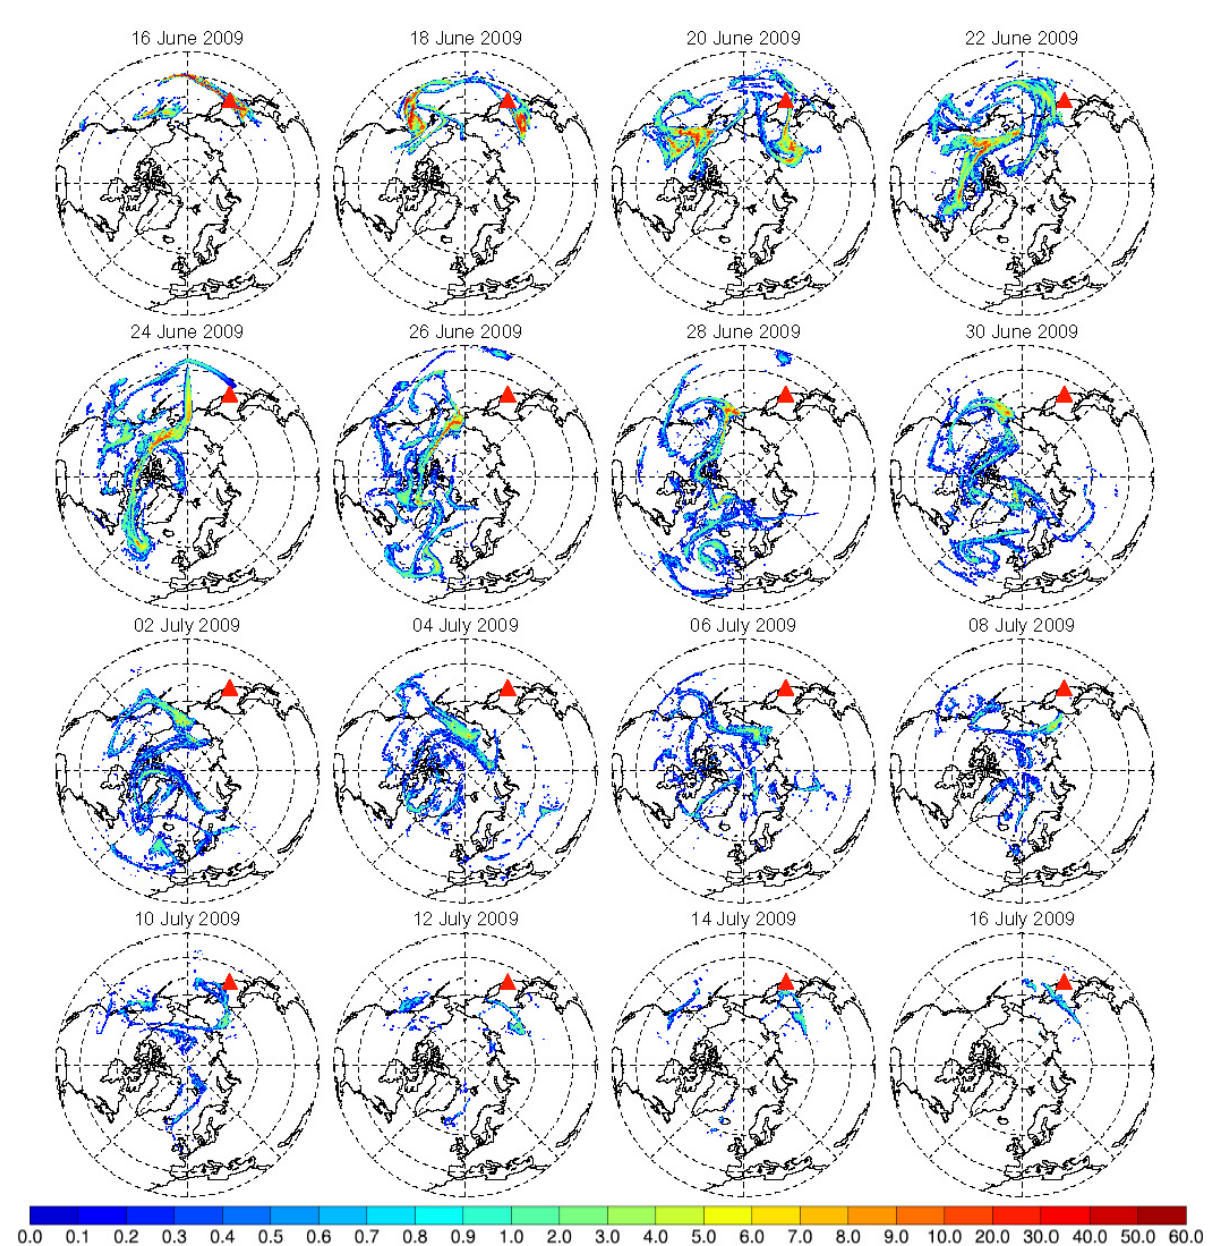
Fig. 2. Evolution of plumes of SO 2 over the Northern Hemisphere observed by the IASI instrument on board the METOP-A satellite in Dobson units (DU) for the 16 June–16 July 2009 period. The Sarychev volcano is indicated by the red